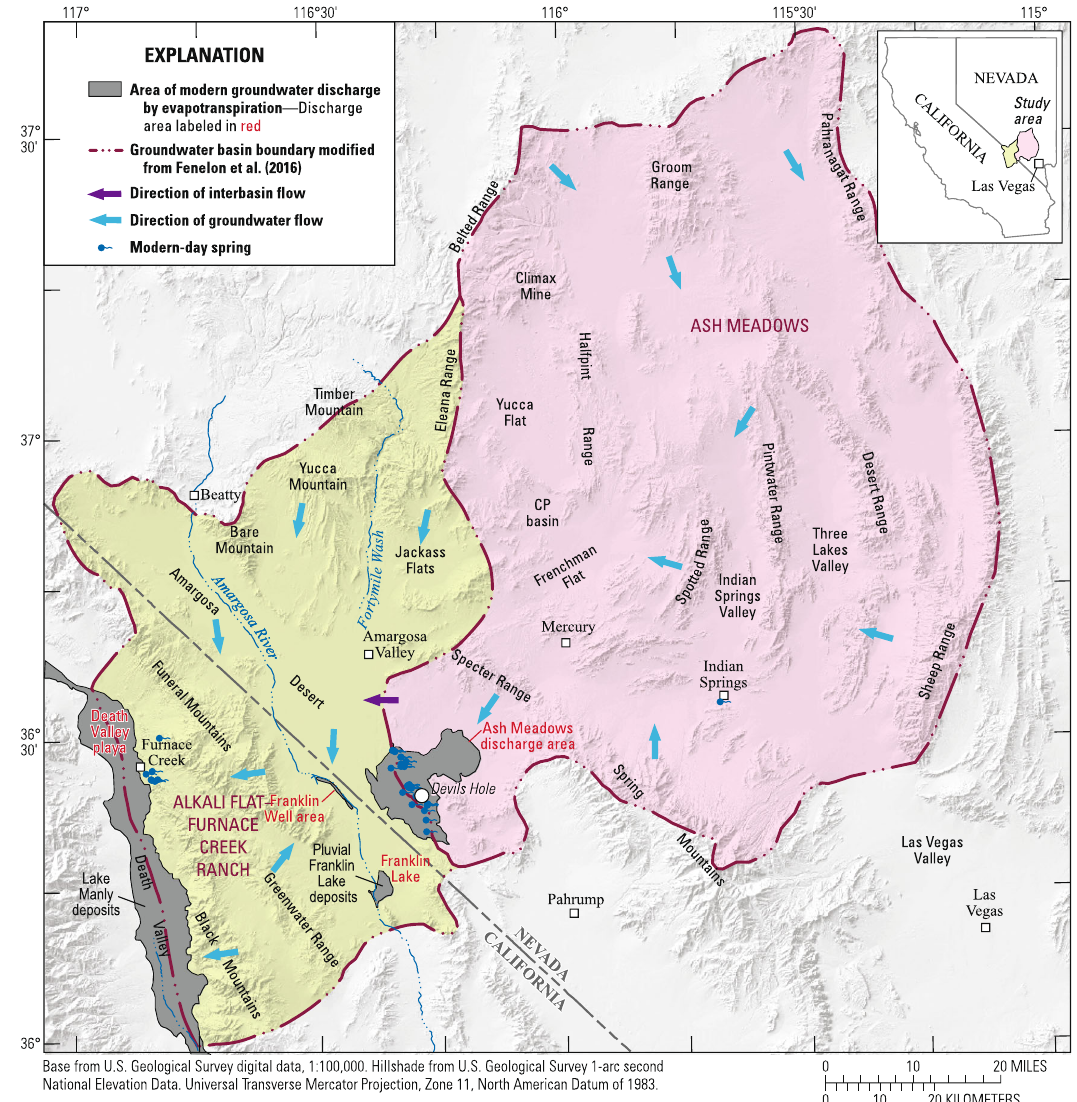
Fig. 1 Map of the study area. Map of the study area, which includes the Ash Meadows and Alkali Flat-Furnace Creek Ranch groundwater basins in southern Nevada and California, USA. Figure modi fi ed from Halford and Jackson 7